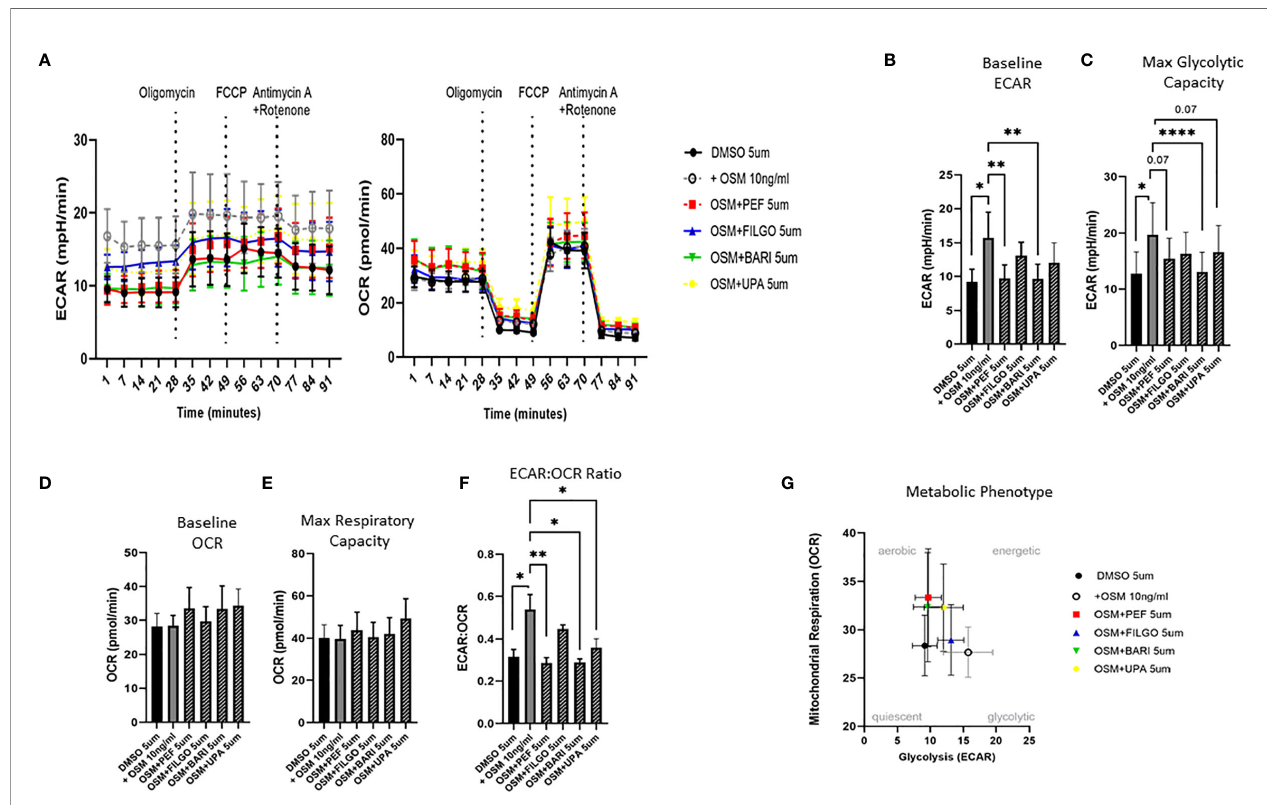
FIGURE 2 | JAKi reduce the increased glycolytic pro fi le of PsAFLS induced by OSM. (A) PsAFLS were treated with JAKi (5 µM) or DMSO (5 µM) for 1 h and stimulated with OSM (10 ng/ml) for 24 h. Average seahorse pro fi les demonstrating extracellular acidi fi cation rate (ECAR) (glycolysis) and oxygen consumption rate (OCR) (oxidative phosphorylation). (B) Representative bar graphs demonstrating baseline ECAR, (C) maximal glycolytic capacity, (D) baseline OCR, (E) maximal respiratory capacity, and (F) ECAR : OCR ratio. (G) Metabolic phenotype pro fi le of PsAFLS, n=6. Values expressed as mean +/- SEM, * p <0.05, ** p <0.01, **** p <0.0001 signi fi cantly different from DMSO+OSM